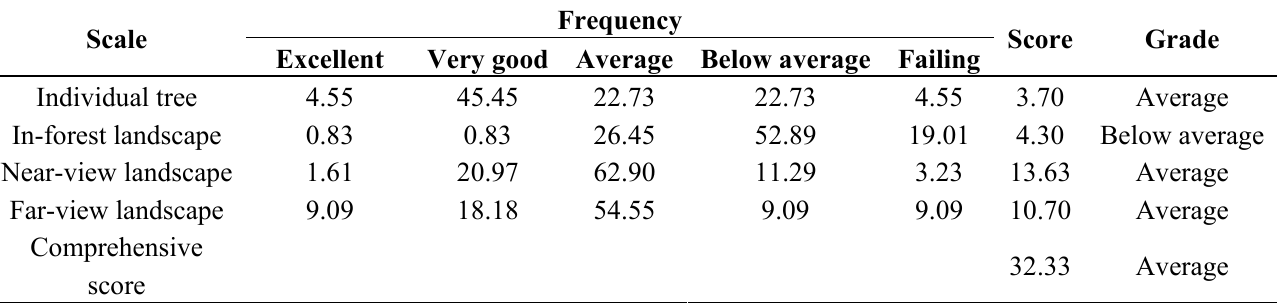
Table 8. Frequency of the grade levels of the Xishan scenic